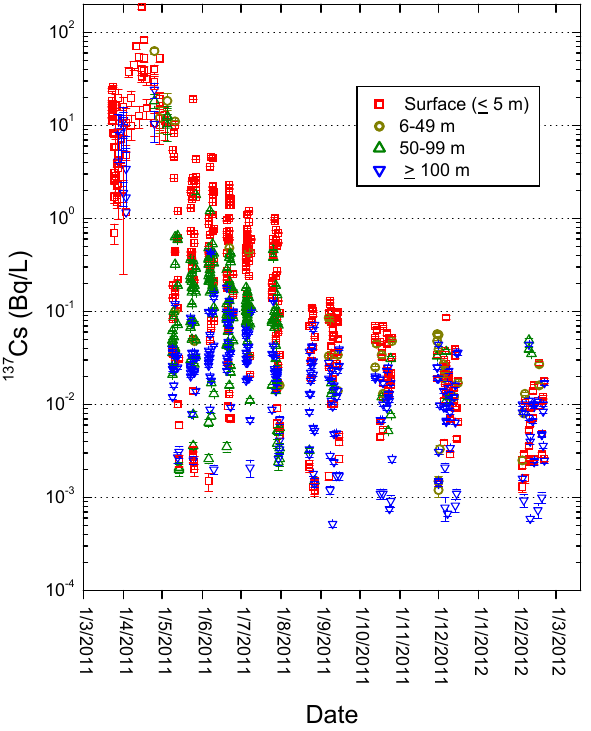
Fig. 3. Temporal variation of 137 Cs activities in coastal waters off Miyagi, Fukushima, and Ibaraki from 23 March 2011 to 21 Febru- ary 2012.